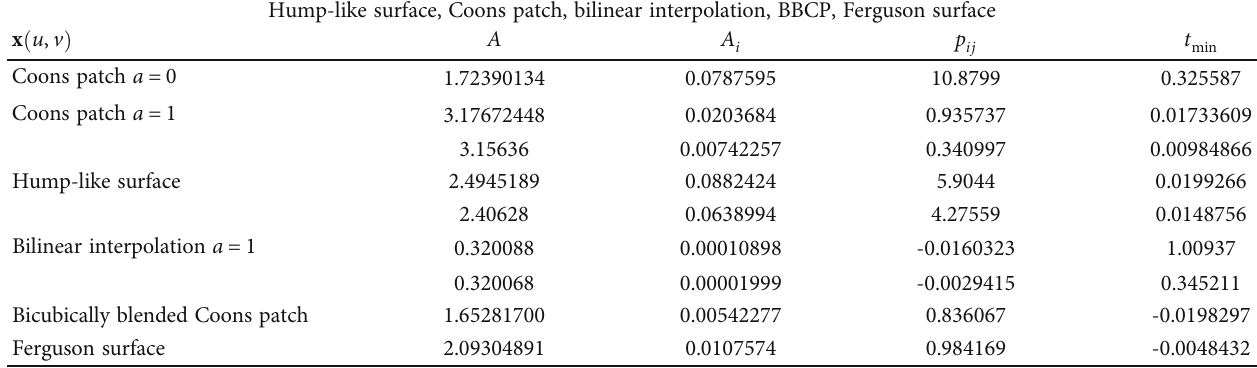
are the decreasing areas and i